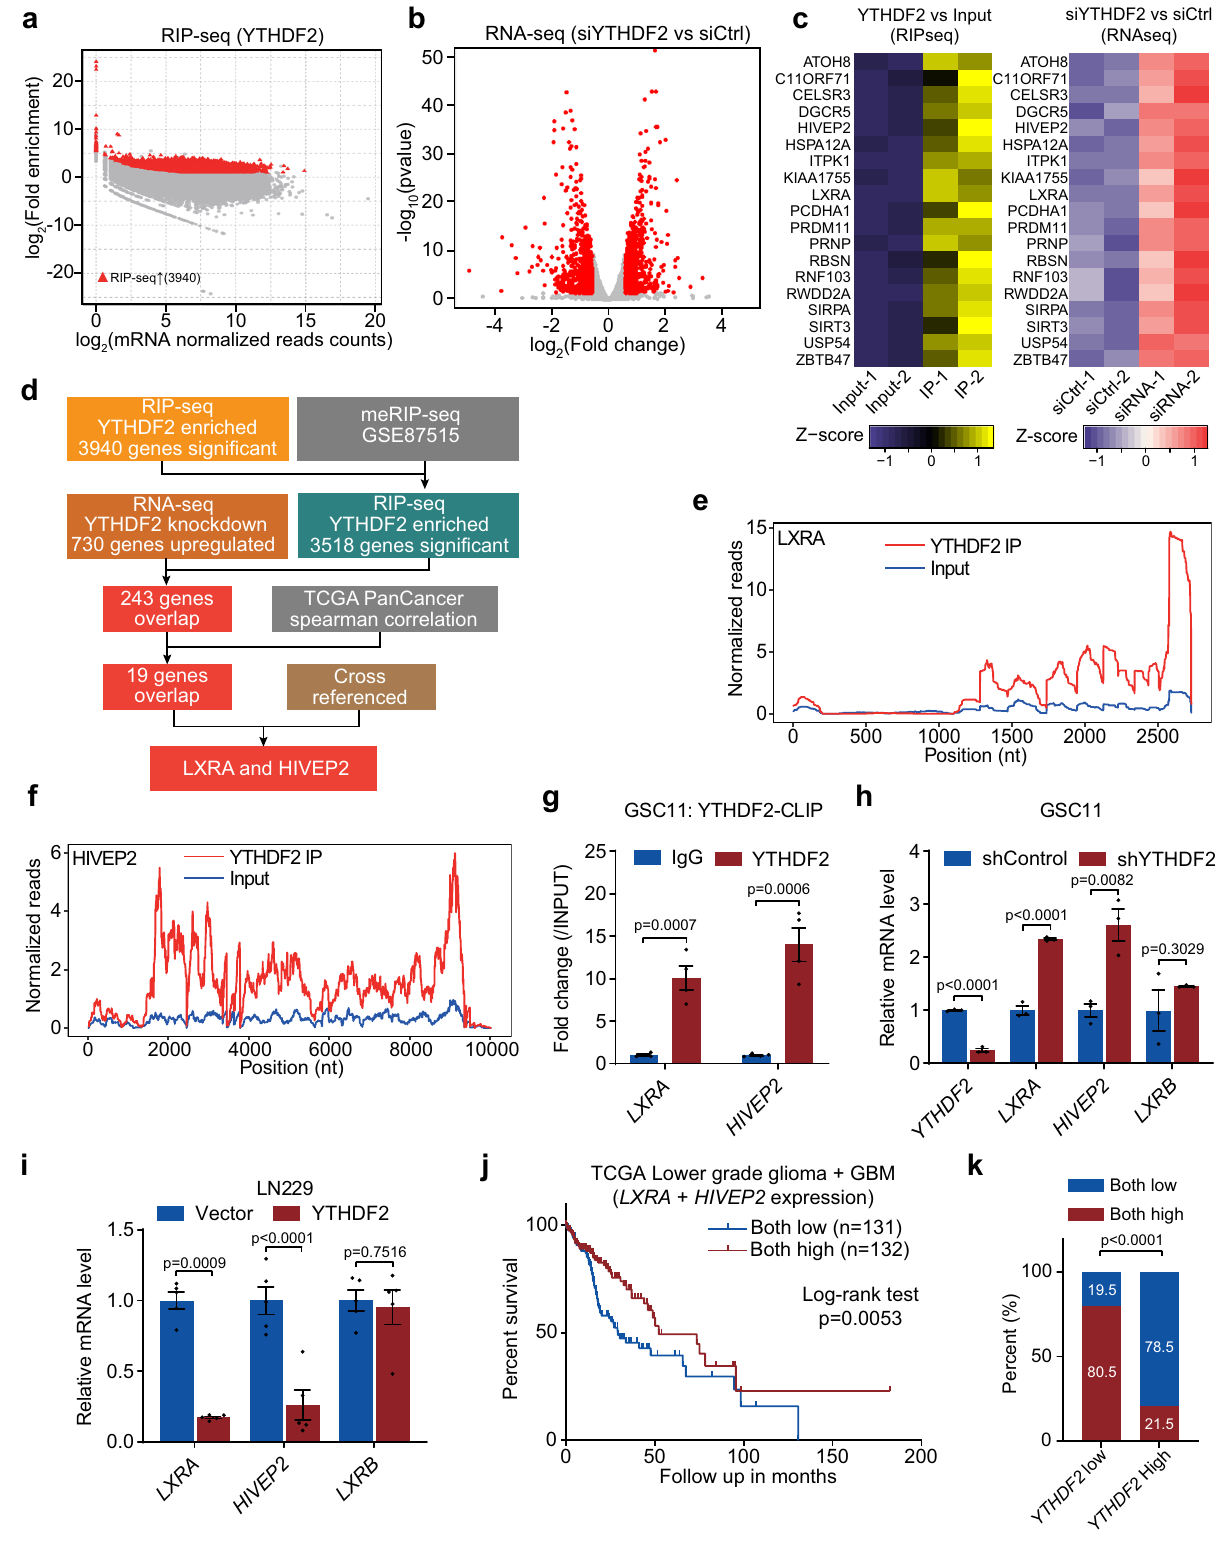
death 12,14 . LXRA expression is signi fi cantly lower than LXRB in GBM 12 . We found that YTHDF2 was highly expressed in GBM and mediated mRNA clearance of LXRA but did not affect the mRNA of LXRB . In fact, in the TCGA glioma dataset, the levels of YTHDF2 is inversely correlated with the levels of LXRA . Thus,